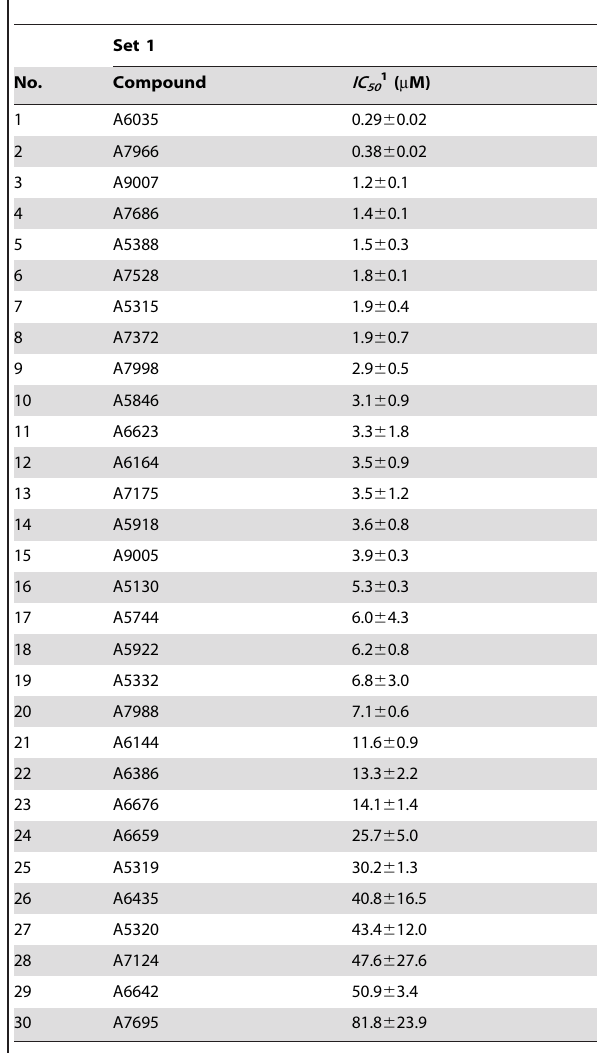
Table 1. IC 50 values of the representative set of active compounds identified in the